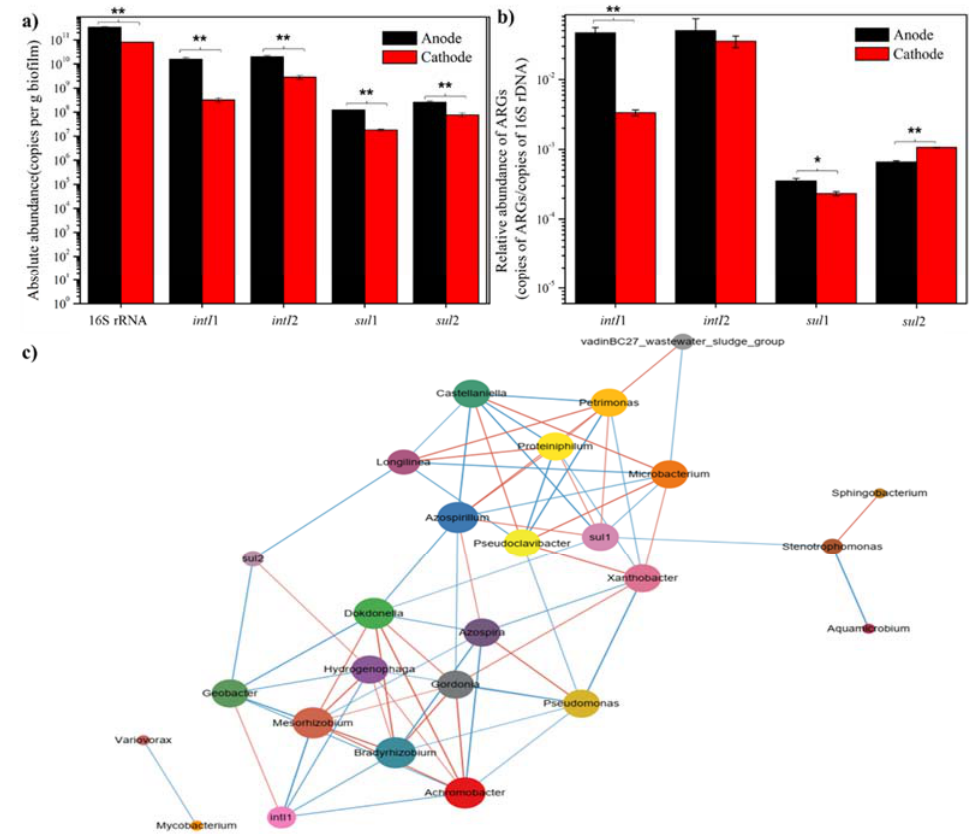
Figure 6. ( a ) Absolute abundance of ARGs; ( b ) Relative abundance of ARGs. (Analysis of difference between anode and cathode: * p < 0.05, ** p < 0.01); ( c ) Network analysis of ARGs and the bacterial community in MFCs. Species with p < 0.05 were shown by default according to Spearman’s rank analysis. Node size was weighted according to the degree. The orange color represents the positive correlation, and the blue represents the negative correlation.